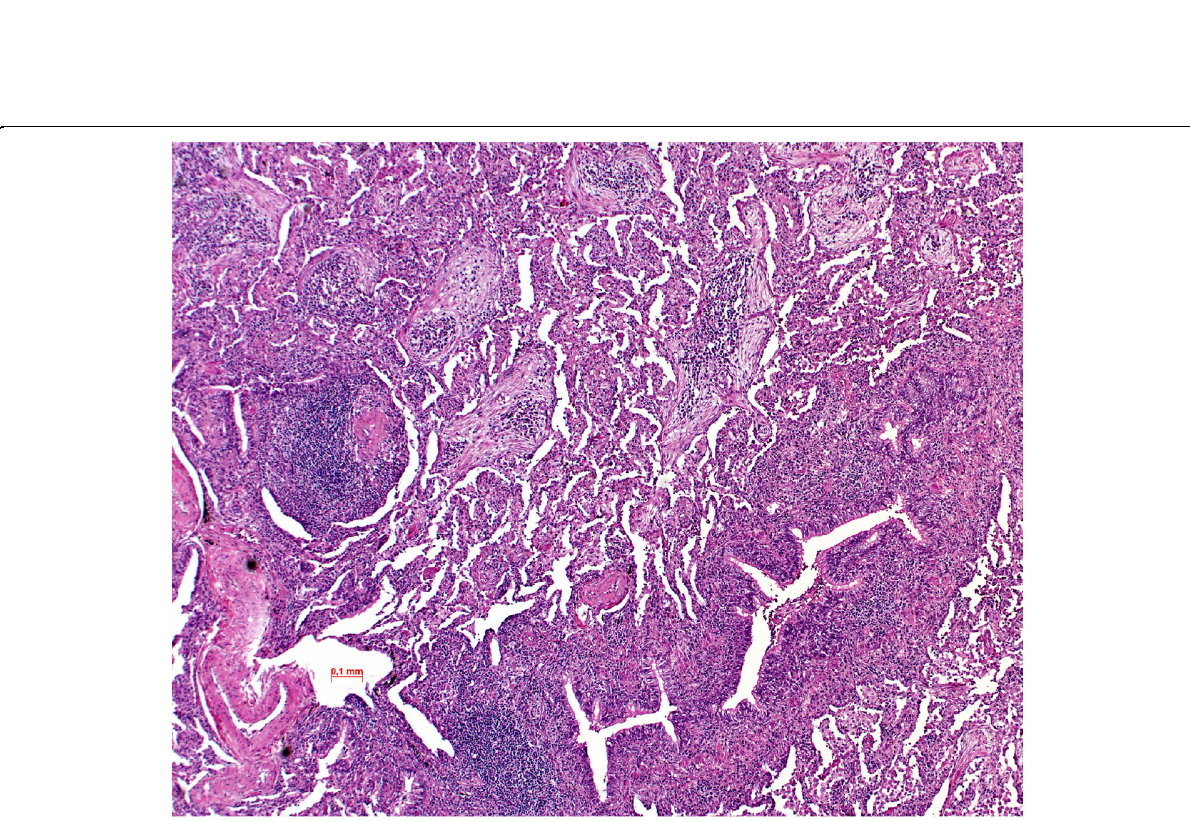
Fig. 23 OP in a case of autoimmune disease; note the combination of OP and LIP with BALT hyperplasia. H&E, bar 100 μ